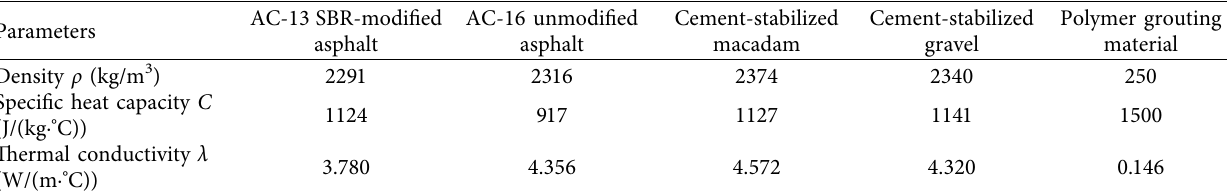
Table 1: Thermal properties of the subgrade materials.